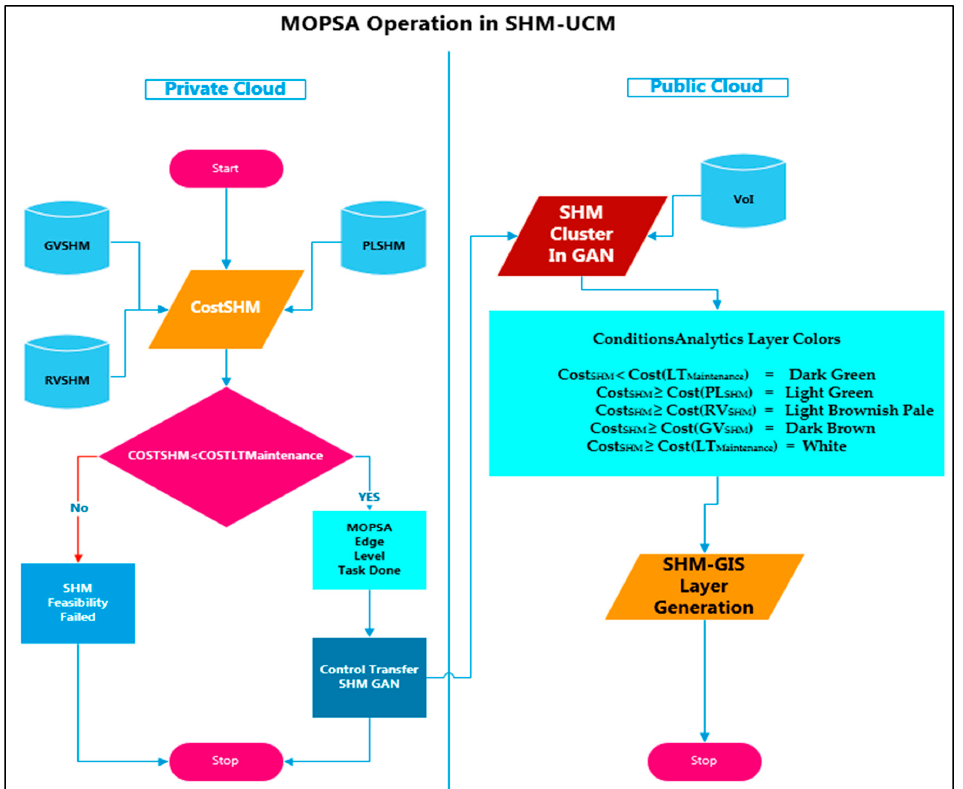
Figure 8. MOSPA Working Model or Operation in SHM ‐ UCM.